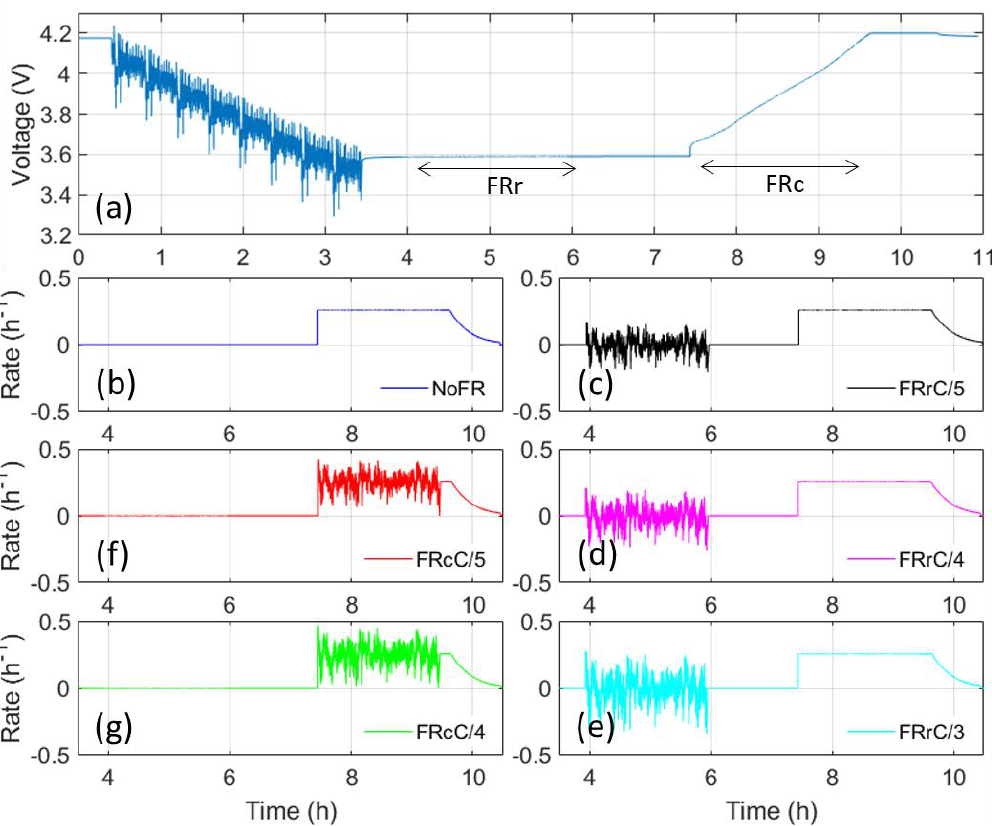
Figure 1. ( a ) Full duty cycle and ( b–g ) charge scenarios for the six duty cycles. noFR: no frequency regulation, FRc: frequency response during charge, and FRr: frequency regulation during rest.